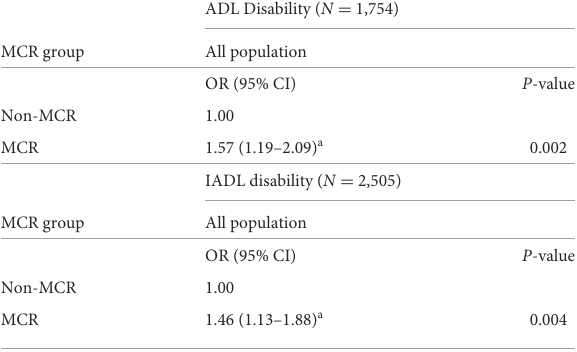
TABLE 3 Multiple logistic regressions presenting the longitudinal association of MCR with ADL disability and IADL